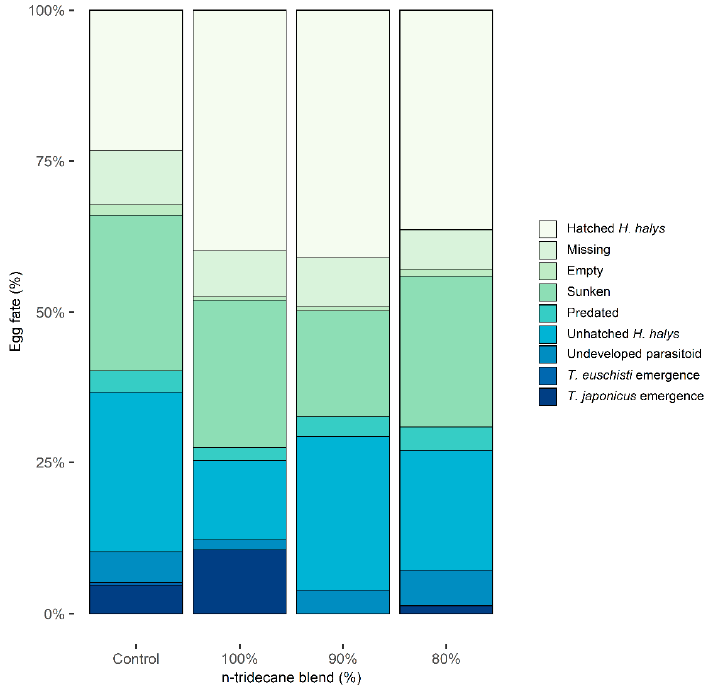
Figure 2. Fate of field-deployed Halyomorpha halys eggs ( n = 2472) in each kairomone lure treatment, shown as percentage of total eggs. Lure treatments are labeled based on percentage of n-tridecane attractant to (E)-2-decenal repellent: hexane (control, n = 598), 100% ( n = 615), 90% ( n = 617), and 80% ( n = 597). A total of 6 egg mass deployments were made in Salt Lake City, UT, USA from 24 June through 27 August 2021. Table 1. Number of Halyomorpha halys egg masses parasitized (and percent of eggs with wasp emergence) in kairomone lure treatments for observed parasitoid species. Lure treatments are labeled based on percentage of n-tridecane attractant to (E)-2-decenal repellent; the control contained only hexane. Ninety-two H. halys egg masses were deployed containing 2472 eggs on Catalpa speciosa leaves in Salt Lake City, UT, USA, from 24 June through 27 August